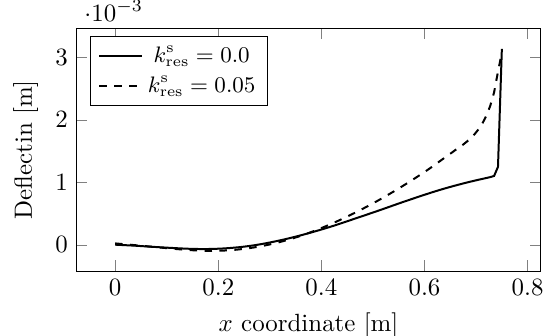
Figure 5. Deflection distribution on line { ( x, y ) | y = 0 . 75 } .